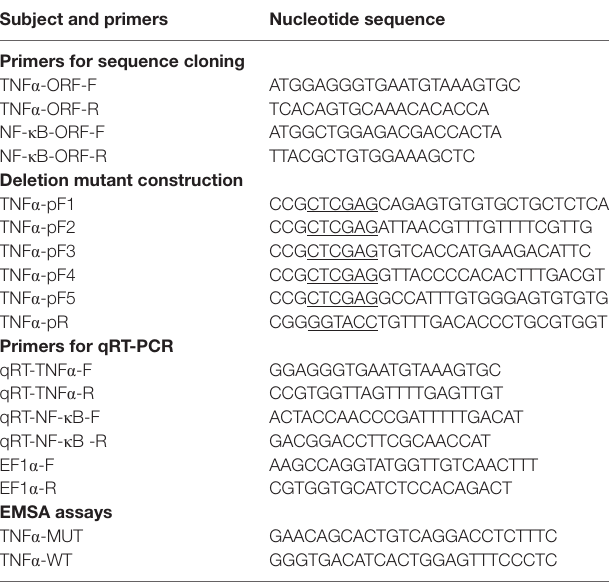
TABLE 1 | Primers used for sequence cloning, deletion mutant construction, mRNA construction and